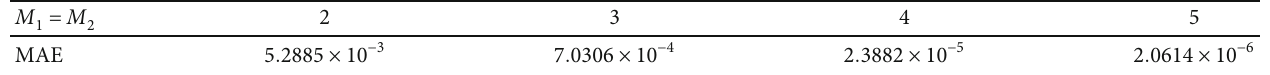
Table 1: Maximum absolute errors for μ = 1 and di ff erent values of M